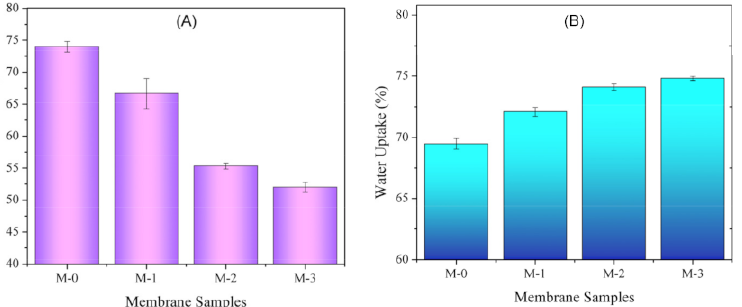
Figure 3. Surface water contact angle ( A ) and water uptake rate ( B ) of the membrane